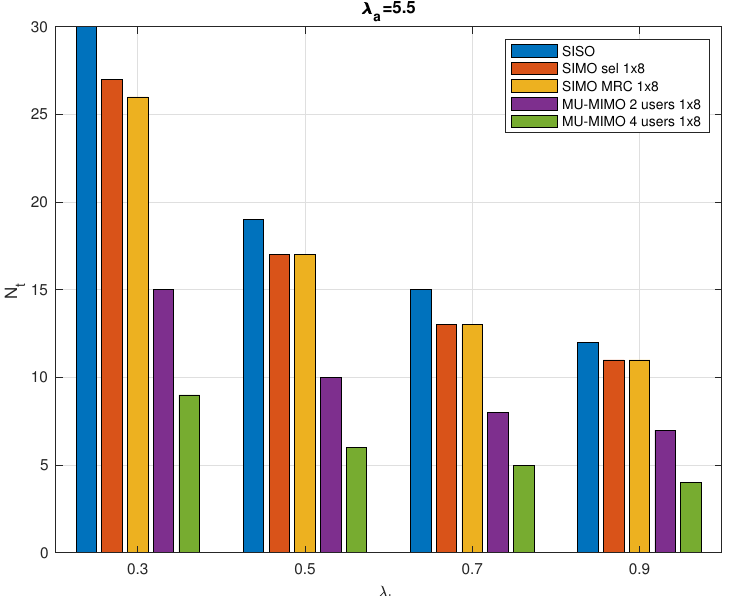
Figure 6. Total number of required RRs in a typical cell versus the collector intensity λ b with λ a = 5.5 nodes/km 2 , τ max = 1